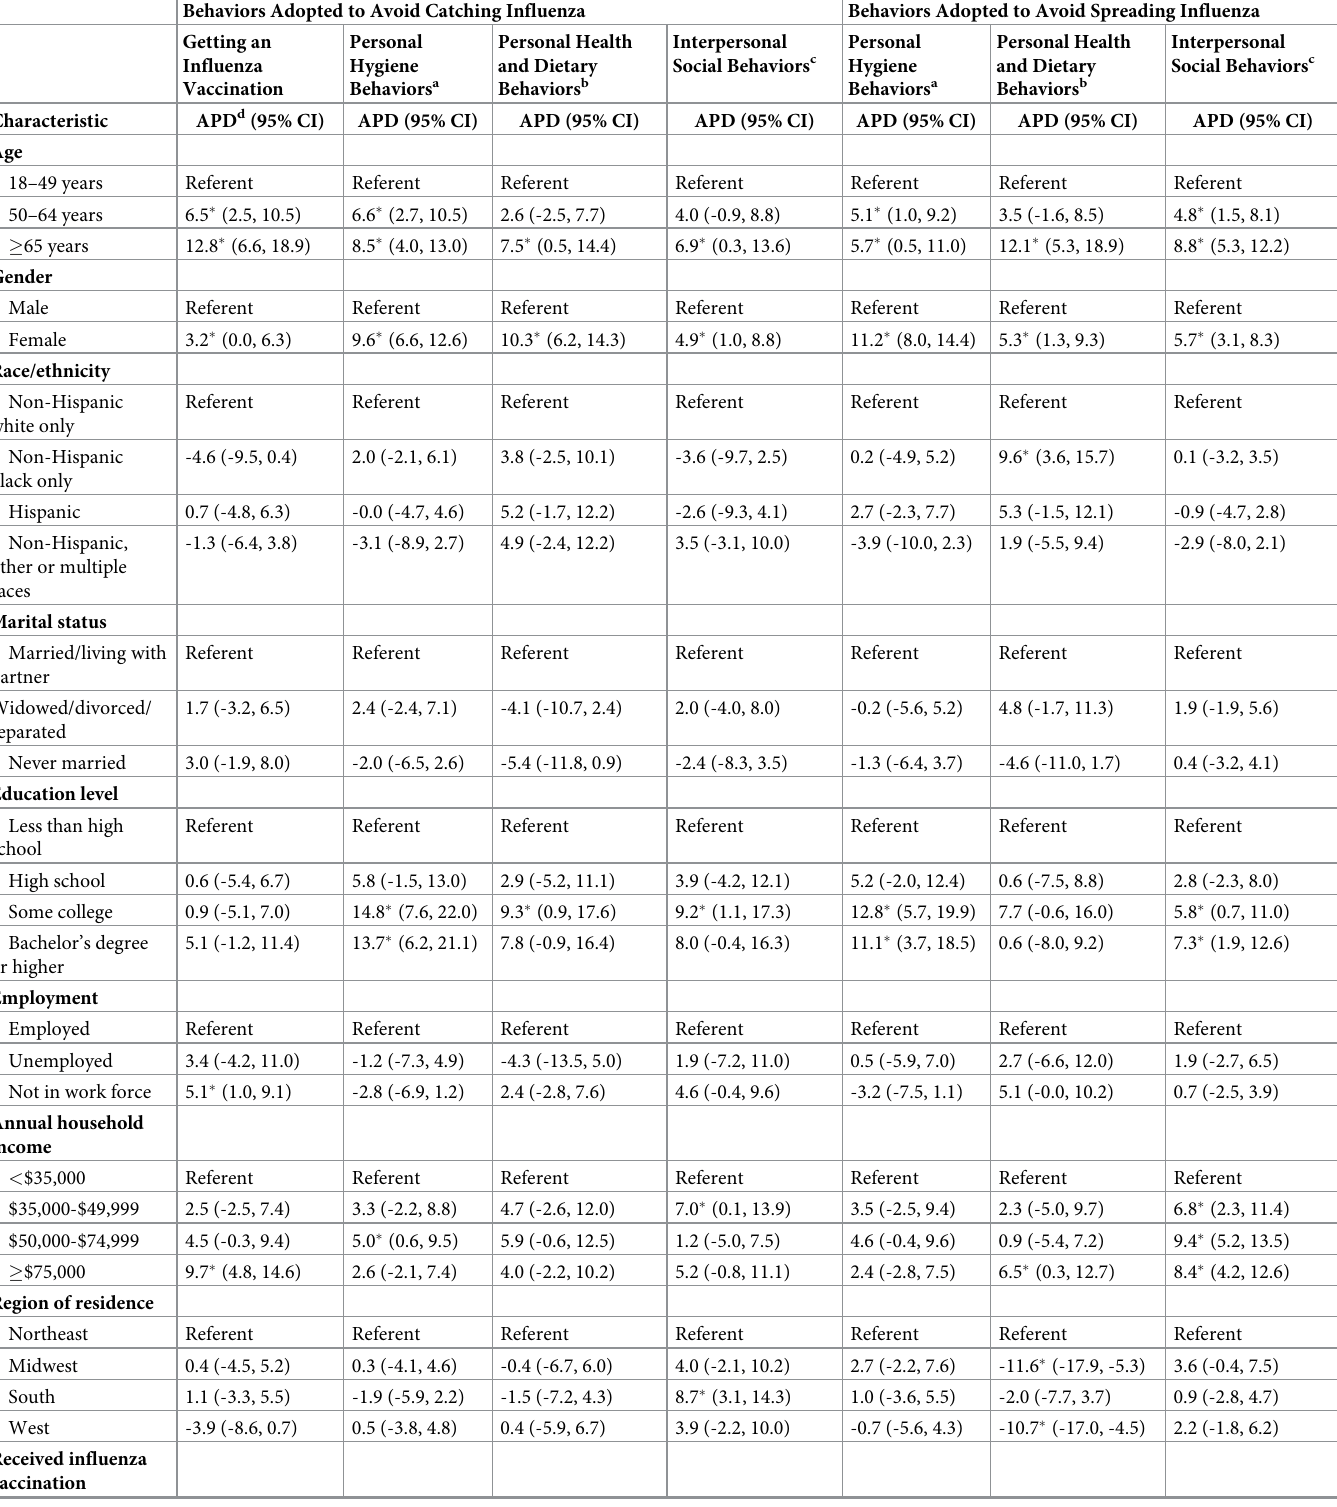
Table 3. Adjusted estimates of preventive behavior responses used by adults to avoid catching or spreading